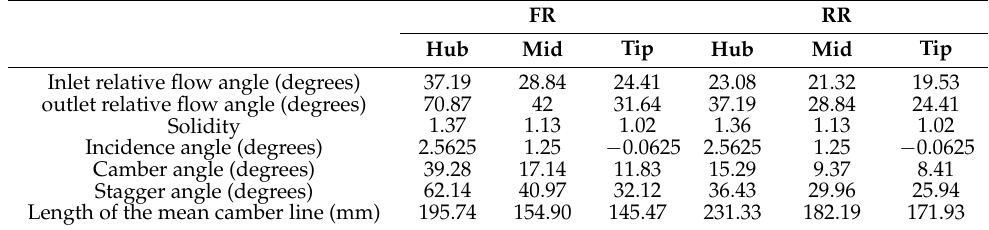
Table 2. The profile data of the baseline